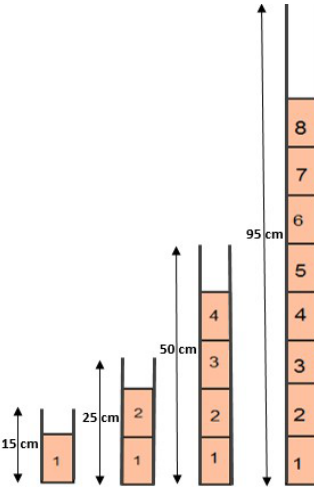
Figure 1. Illustration of cemented hydraulic fill (CHF) samples prepared in four columns; the number indicates the position of each sample of 10 cm high.